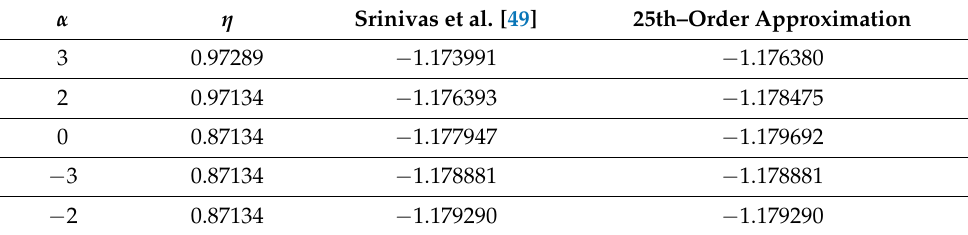
Table 2. Variation of radial velocity in the suction case for the viscous fluid; M = 0, R = − 100. α